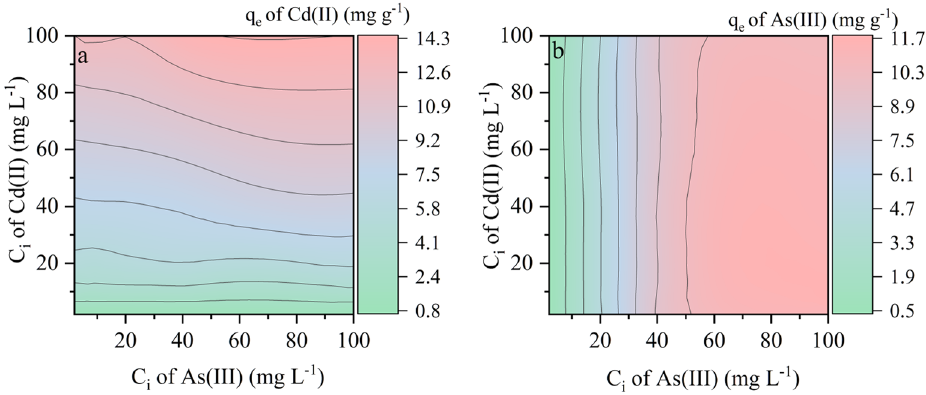
Figure 2. Mutual effect of Cd(II) (C i of 1–100 mg L −1 ) and As(III) (C i of 1–100 mg L −1 ) on adsorption capacities of Fh@BC for Cd(II) (a) and As(III) (b) in the binary system with simultaneous addition.